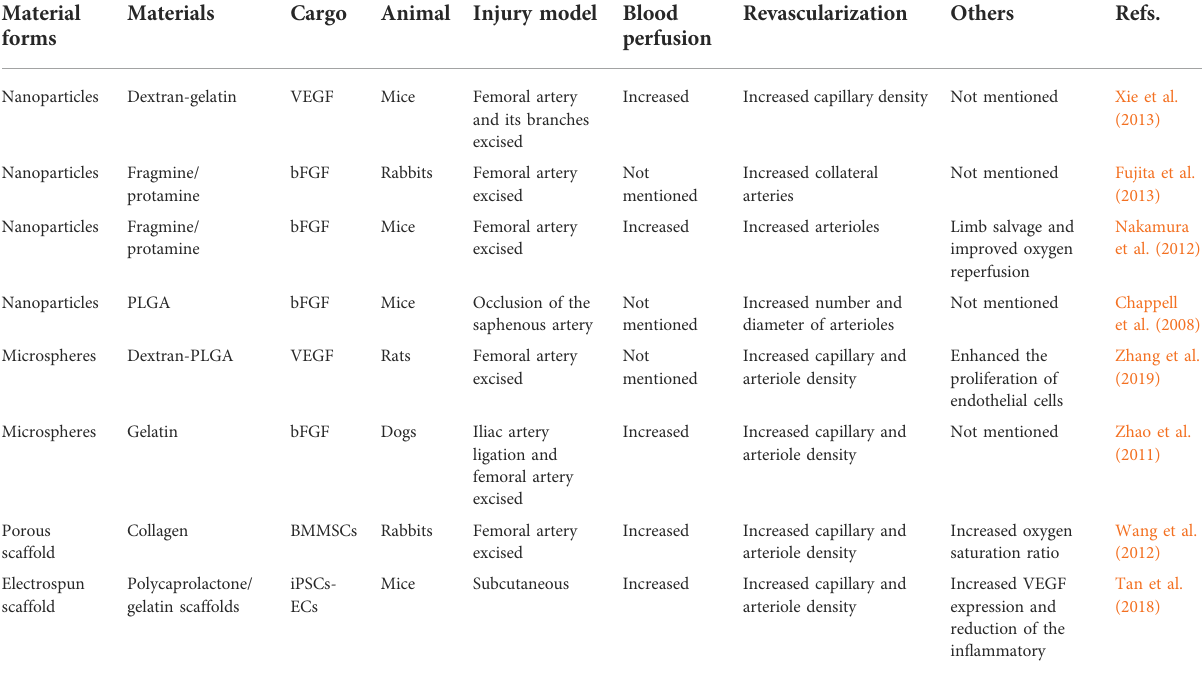
TABLE 4 Preclinical studies of other biomaterials for